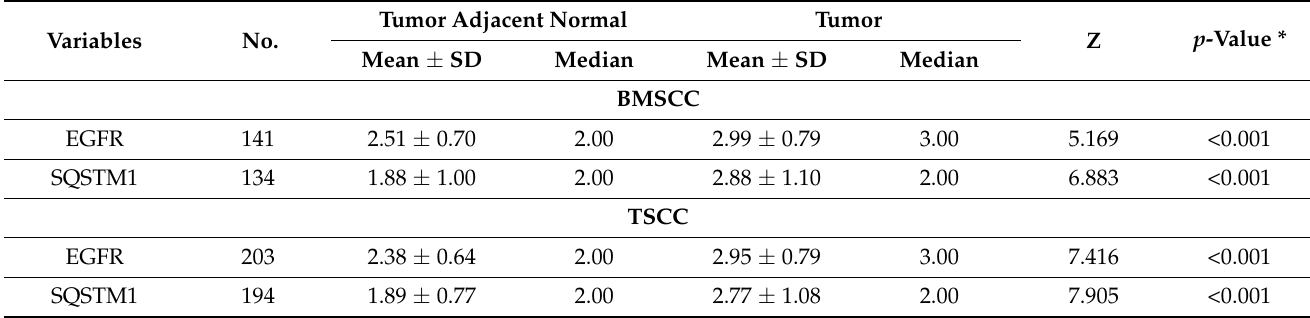
Table 1. The comparison of EGFR and SQSTM1expressions between corresponding tumor adjacent normal and tumor tissues in OSCC patients. Tumor Adjacent Normal Tumor Table 1. Cont . Variables No.